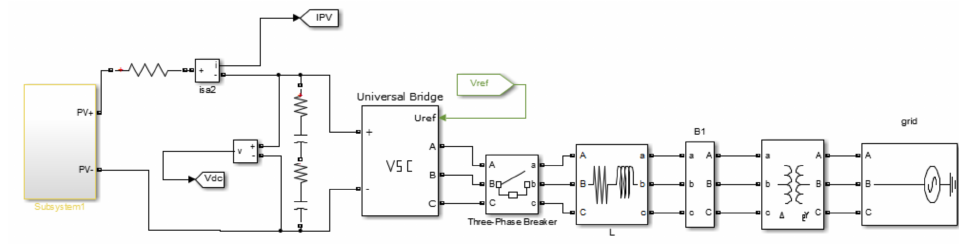
Figure 3. Circuit diagram of grid-connected PV system